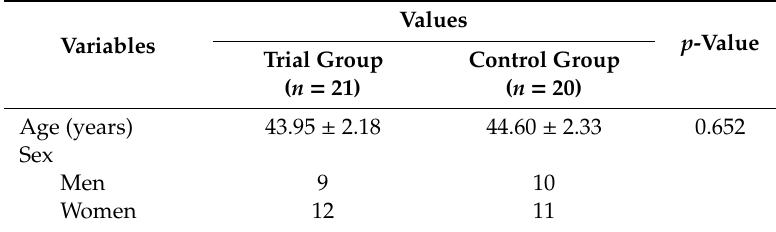
Table 2. Baseline characteristics of the patients in each group. Variables